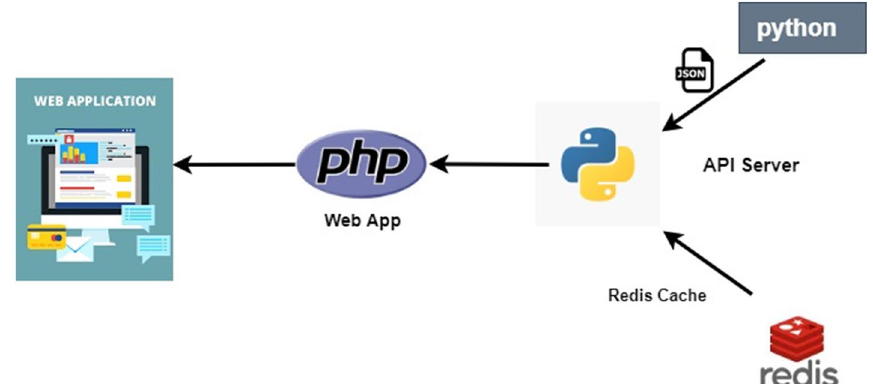
Fig. 2 Microservices stack of a big data application